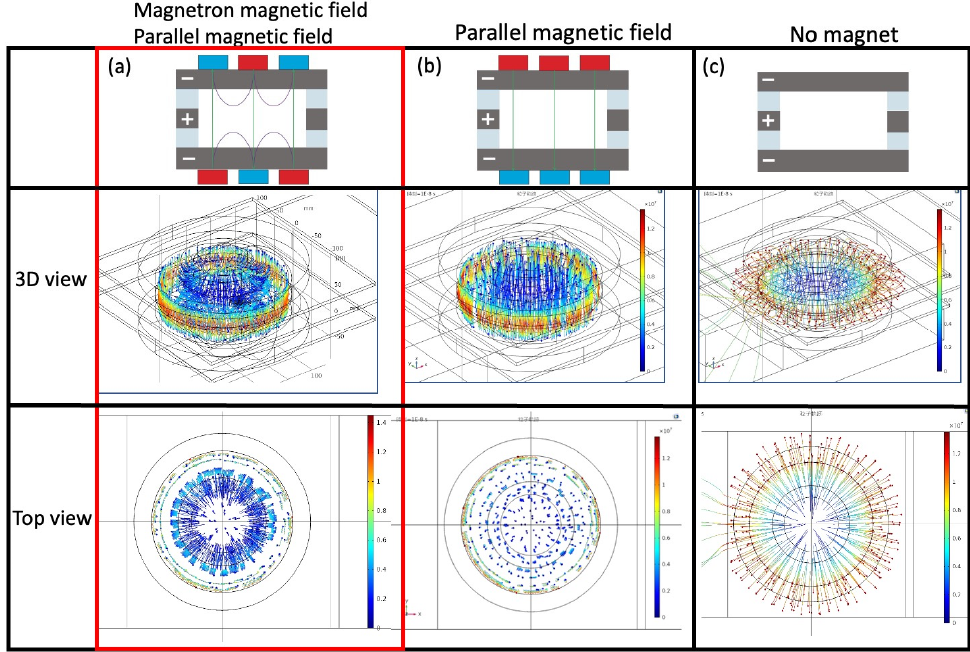
Figure 3. Electron trajectory calculated by 3D finite element analysis for three different magnetic circuits.